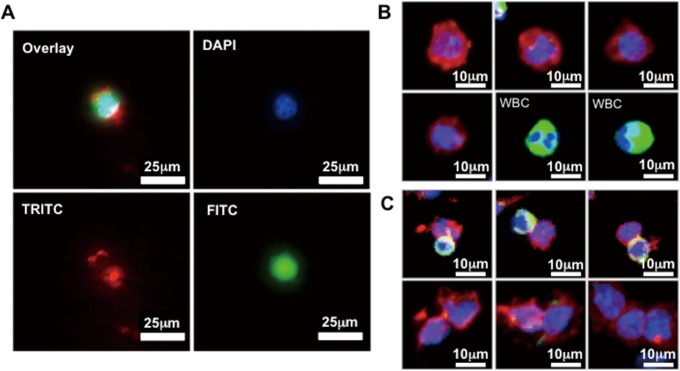
Release of captured cells by air foams from CMx platform.(A) The florescent images of the HCT116 cancer cell released from the Texas Red-SLB coated chip. The cell was wrapped with Texas Red-SLB lipid molecules around the membrane (blue: DAPI; green: pre-stained CellTracker Green CMFDA; red: Texas Red conjugated lipid molecule). (B and C) Overlaid fluorescent images of the released single CTC and CTM for cell characterization. Eluted cells from clinical samples were categorized as CTC by size, morphology and immunostainning (DAPI+/CK20+/CD45-). WBCs were identified by DAPI+/CK20-/CD45+ immunostaining (blue: DAPI; green: CD45; red: CK20).